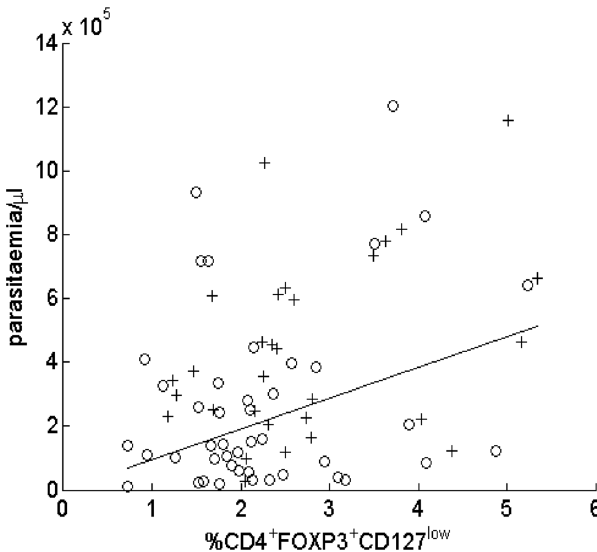
Figure 2. Proportion of T cells expressing a Treg phenotype correlates with parasitaemia. Parasite density in peripheral blood is plotted against the proportion of Tregs. + : severe cases; # : uncomplicated cases. P value for linear regression ignoring disease status: 0.002. (gradient for separate lines for uncomplicated and severe cases not significantly different).